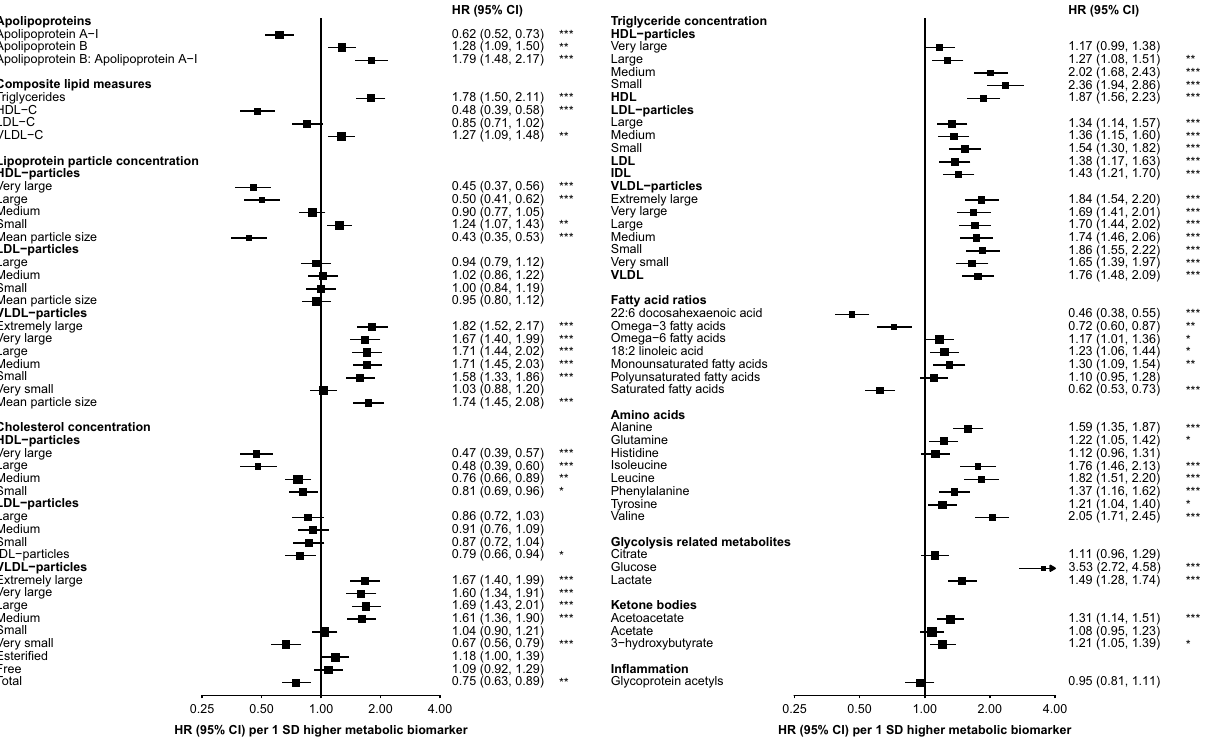
Figure 1. Associations of circulating metabolic biomarkers with risk of incident type 2 diabetes. Adjusted for age, sex, study area, education, fasting time, smoking, alcohol, physical activity, dietary factors, family history of diabetes, BMI and waist circumference. Squares represent the HR per 1 SD higher metabolic biomarker. Horizontal lines represent the corresponding 95% CI. Fatty acid ratios represent ratios of individual to total fatty acids. *p ≤ 0.05, **p ≤ 0.01, ***p ≤ 0.001 after adjustment for multiple testing using Benjamini–Hochberg Correlations between directly measured metabolic biomarkers are presented in Supplementary Fig. S1. Overall, 178 of the 225 metabolic biomarkers, across multiple molecular pathways, were associated with risk of incident T2D at false discovery rate (FDR) controlled p < 0.05 after adjustment for age, sex, study area, education and fasting time, of which 134 were significant at FDR-controlled p < 0.01 (Supplementary Table S1, Supple- mentary Figs. S2, S3). After additional adjustment for lifestyle factors, family history of diabetes and adiposity, 163 biomarkers remained statistically significantly associated with T2D at p < 0.05 and 138 at p < 0.01. Further adjustment for random plasma glucose (RPG) moderately attenuated most associations, but the majority (n = 147 at p < 0.05; n = 129 at p < 0.01) remained statistically significant. Lipoproteins and incident T2D. There were positive associations with incident T2D risk of apolipopro- tein B/apolipoprotein A1 (1.79 [95% CI 1.48–2.17] per 1 SD higher), triglyceride (1.78 [1.50–2.11]) and VLDL- cholesterol (1.27 [1.09–1.48]) concentrations, as well as VLDL particle size (1.74 [1.45–2.08]) (Fig. 1). The concentration of HDL-cholesterol (0.48 [0.39–0.58]) and HDL particle size (0.43 [0.35–0.53]) showed inverse associations with risk of T2D. Higher triglyceride concentrations in all lipoprotein subclasses were associated with higher T2D risks. These risks were moderately stronger for triglyceride concentrations in small (2.36 [95% CI 1.94–2.86]) and medium (2.02 [1.68–2.43]) HDL particles. Triglyceride concentrations in VLDL particles were associated with 65–86% higher risk per 1 SD, with a similar strength of association irrespective of particle size. Each 1 SD increment in cholesterol concentration in medium to extremely large VLDL particles was associated with 60–69% higher risk of T2D, while cholesterol in very small VLDL particles was associated with ~ 30% lower risk. The inverse associa- tions of cholesterol concentrations in large (0.48 [0.39–0.60]) and very large (0.47 [0.39–0.57]) HDL particles were stronger than those of cholesterol concentrations in smaller HDL particles. Amino acids and incident T2D. Branched chain amino acid (BCAA) (leucine, isoleucine, valine) concen- trations were strongly positively associated with risk of incident T2D, ranging from an adjusted HR of 1.76 (95% CI 1.46–2.13) for isoleucine to 2.05 (1.71–2.45) for valine (Fig. 1). Moderately weaker associations (20–60% higher risk per 1 SD increment) were observed with other measured amino acids, with the exception of histidine which showed no clear association with T2D risk.